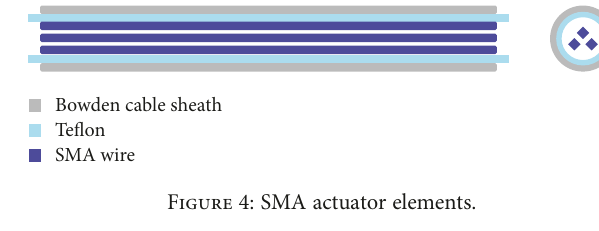
Figure 4: SMA actuator